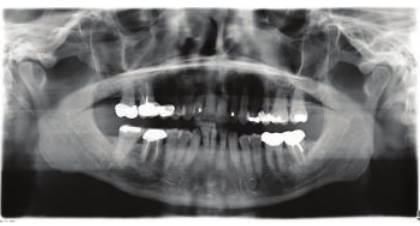
Figure 5: Posttreatment panoramic